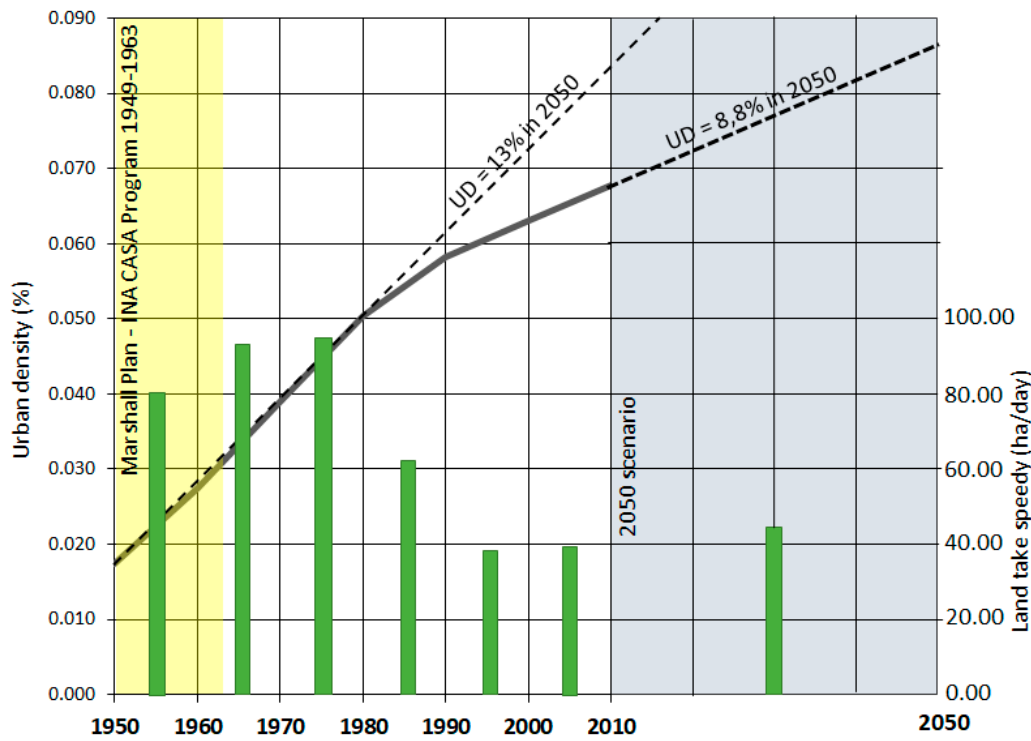
Figure 3. Overall diagram of the dynamics of urbanized areas following the Marshall Plan and subsequent dynamics with an inferential projection until 2050. Land take rates during the different time periods are also shown.